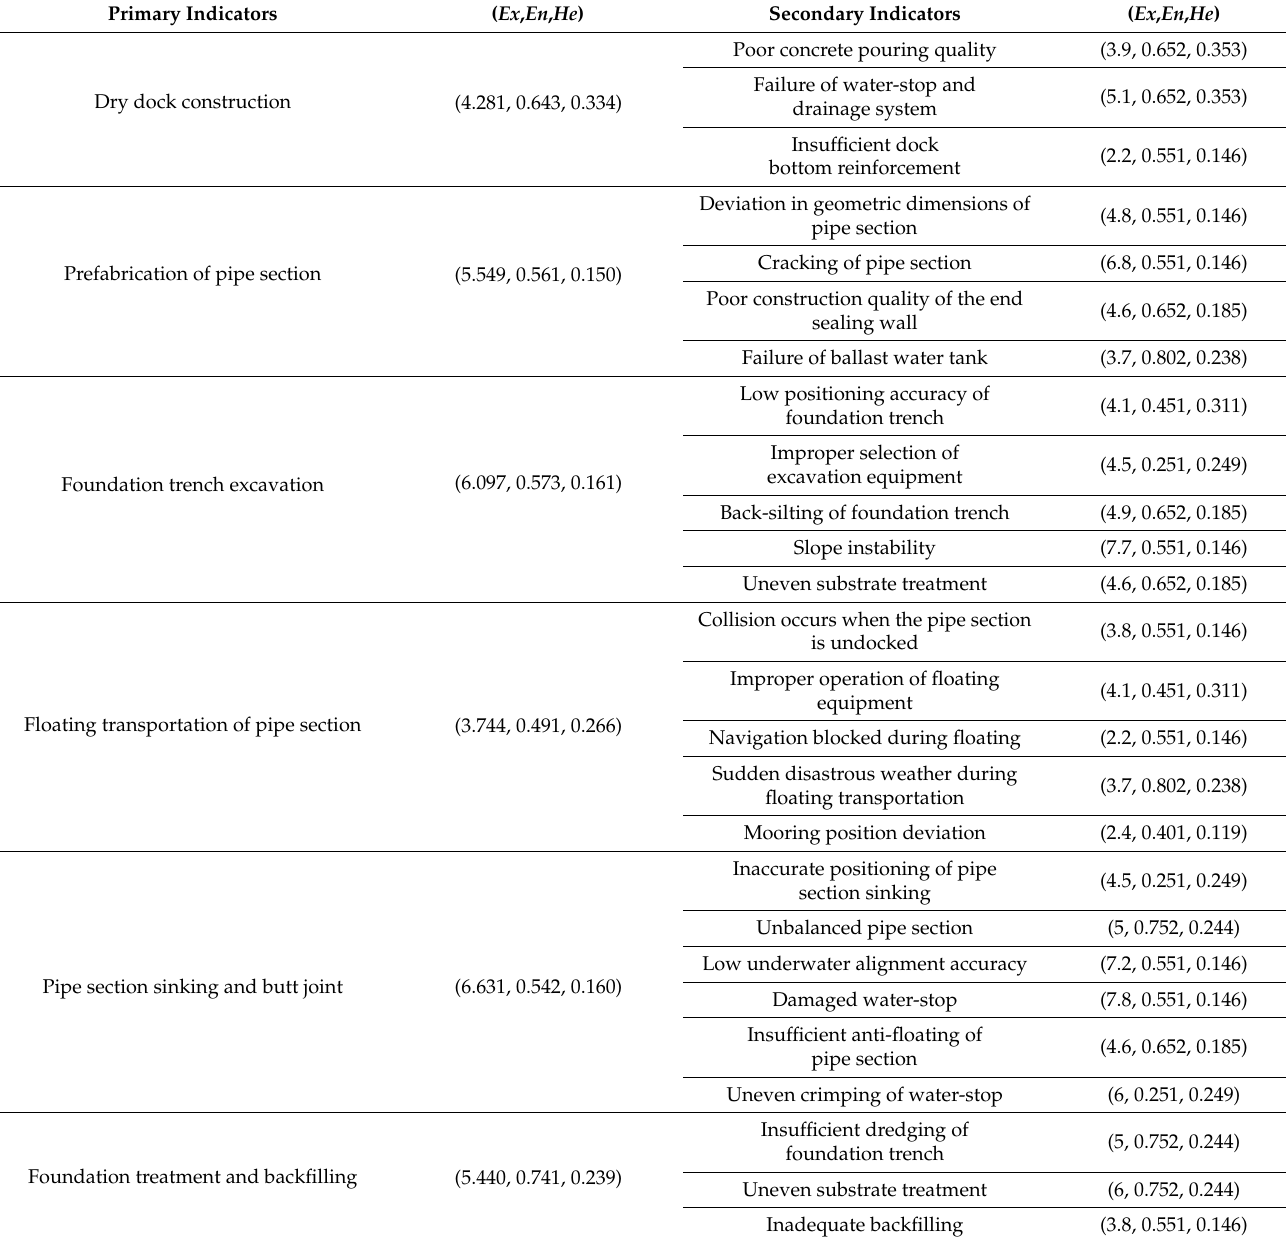
Table 6. Cloud model parameters of each